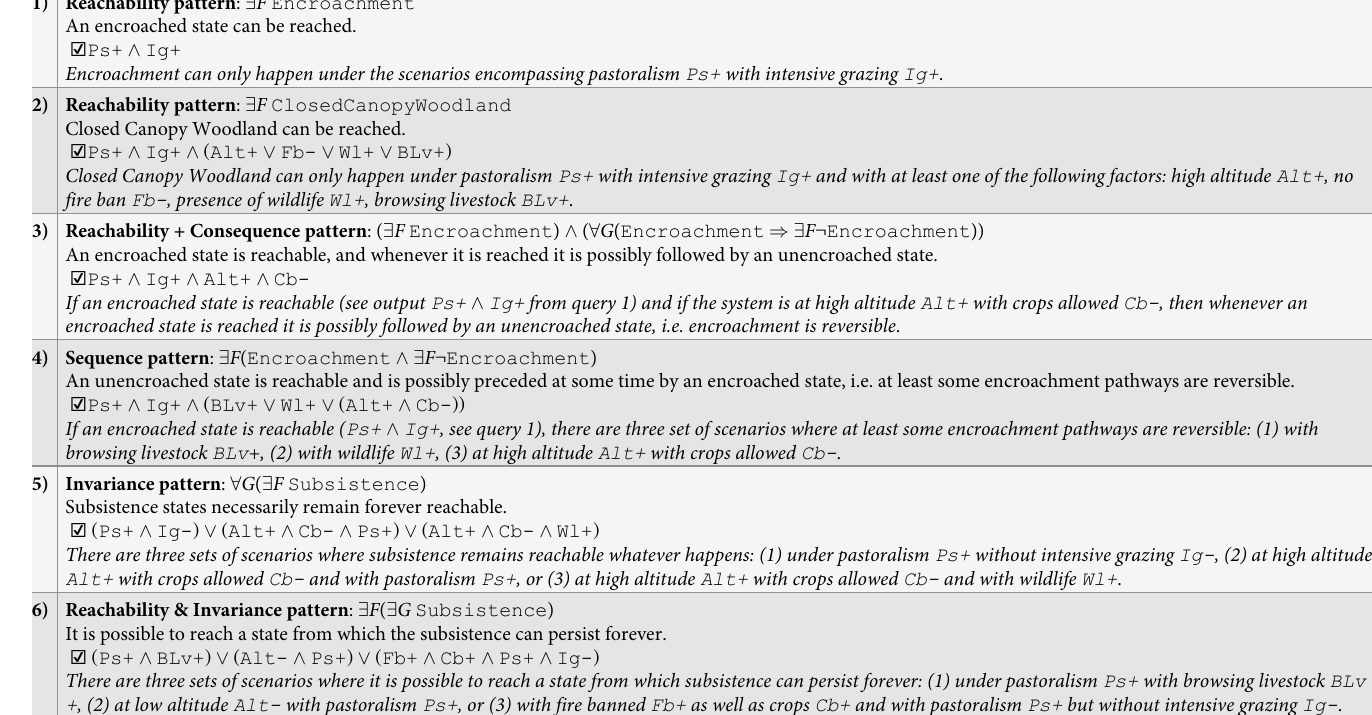
Table 3. Scenario selection by model-checking. For each of the six queries we show: (1) its pattern type and CTL formula, (2) its translation into English, (3) ☑ the sce- nario selection (i.e. control valuations) for which the associated model-checking output of the query is yes , (4) an English interpretation of this scenario